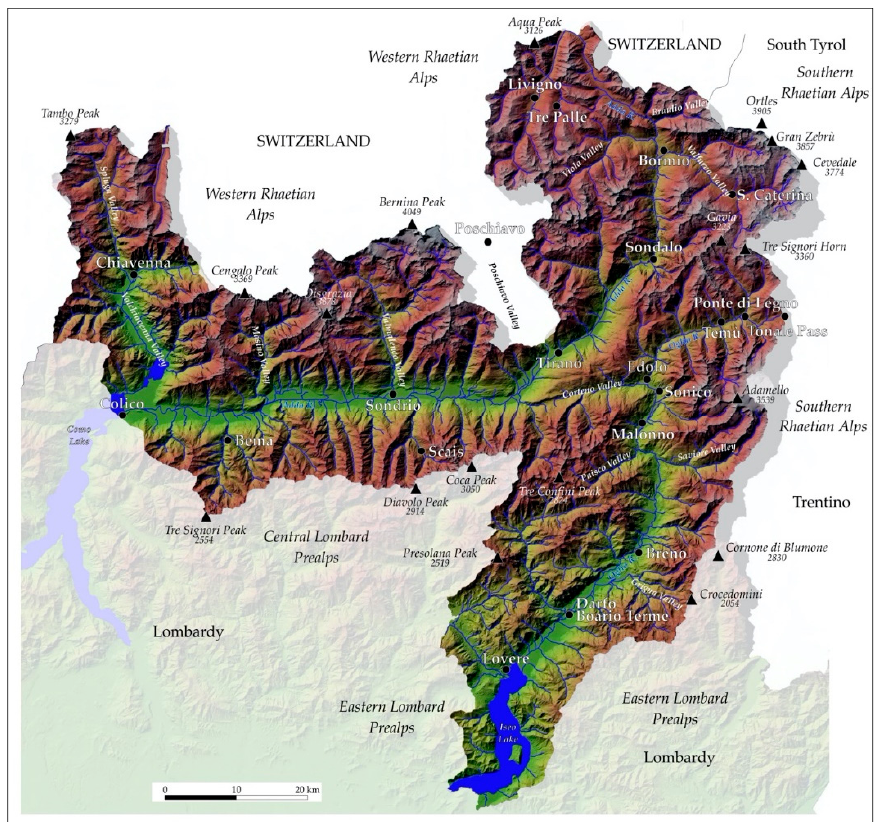
Figure 2. Geographical setting of the Valtellina (Sondrio Province) and Valcamonica (Brescia Province) in the Southern and Western Rhaetian Alps and the Central and Eastern Lombard Prealps (Central- and South-Eastern Alps)